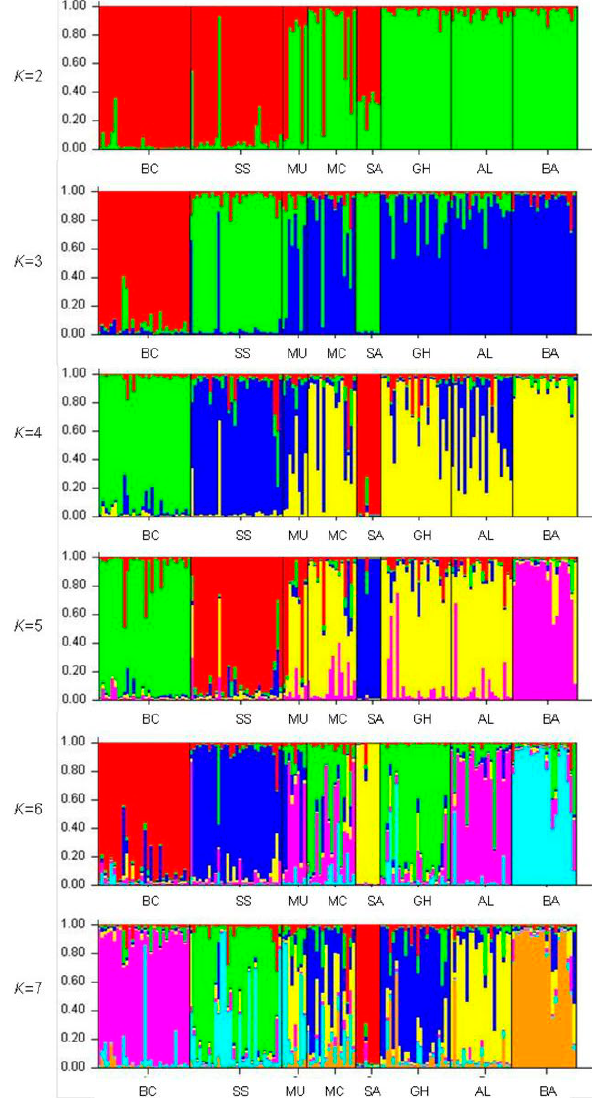
Figure 5. Proportional membership ( Q ) to clusters identified by STRUCTURE for 2< K <7. Colours distinguish between the different K clusters. All studied individuals of R. lamarmorae (sub-popula- tions BC and SS: 60 individuals) and R. corsica (populations MU, MC, SA, GH, AL and BA: 96 individuals) are represented by verti- cal bars and grouped by locality, indicated on the x-axis. Informa- tion on each population (locality) is provided in Table